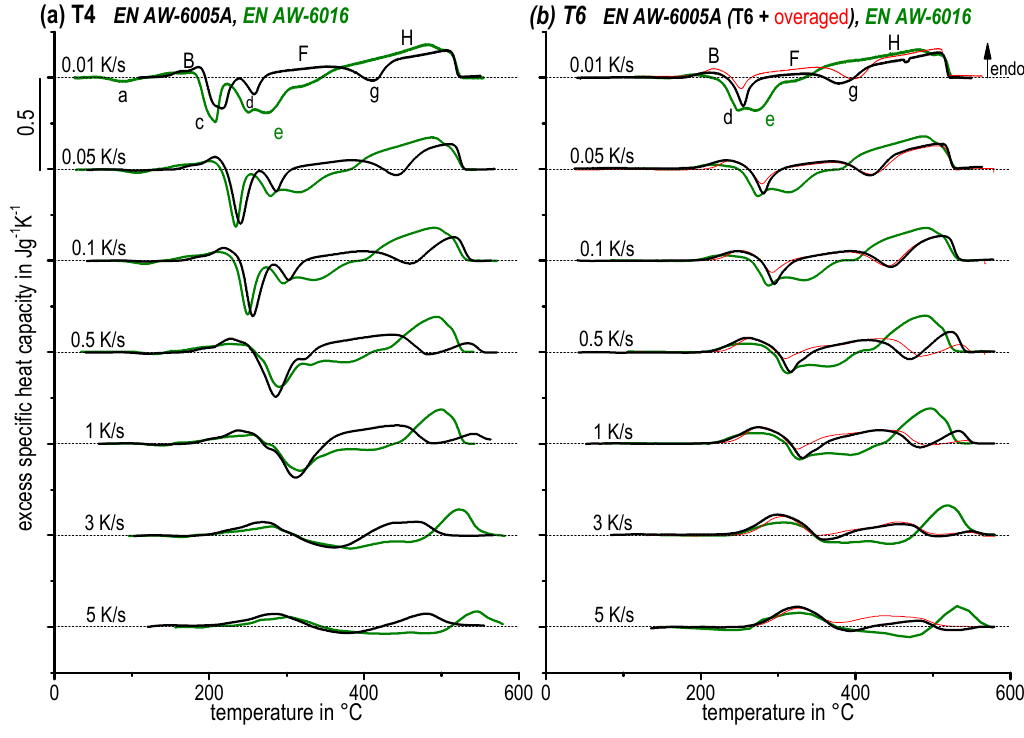
Figure 6. Selected heating curves of EN AW-6005A and EN AW-6016 for the initial conditions ( a ) T4. ( b ) T6 (and